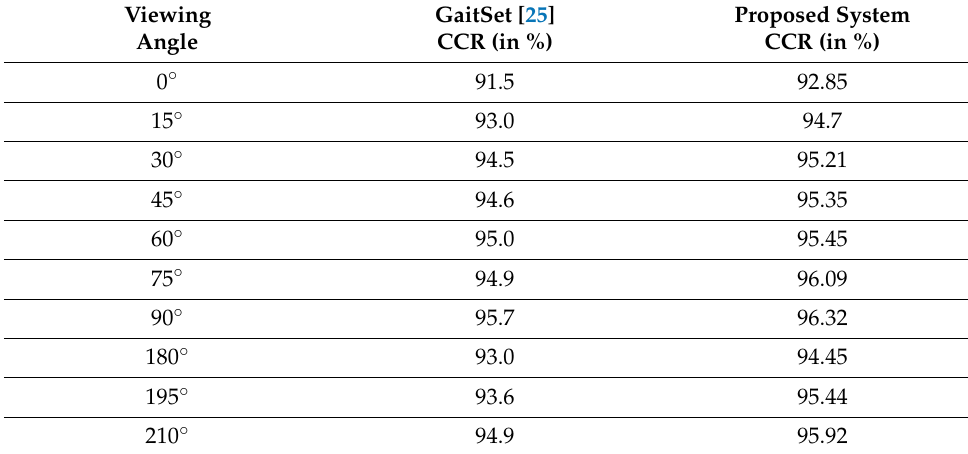
Table 4. Viewing angle-wise comparison of the proposed system with GaitSet